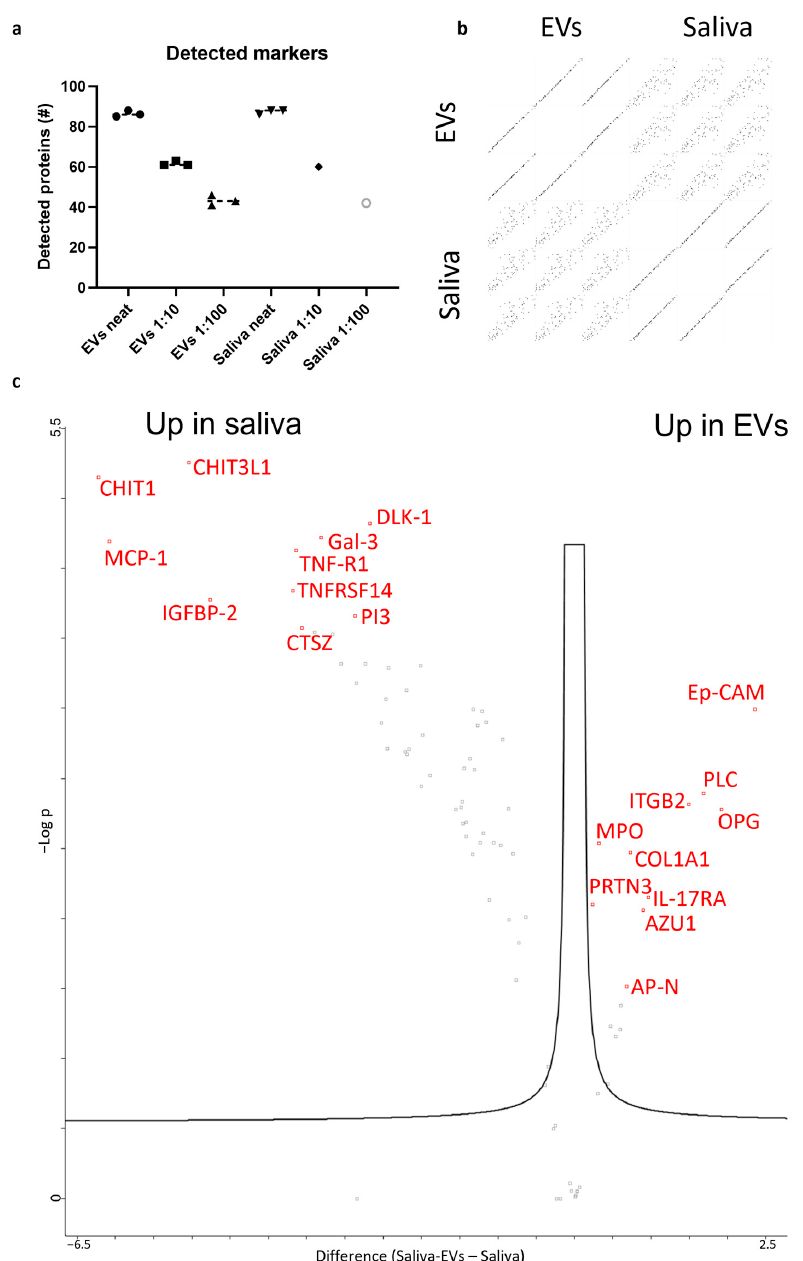
Figure 3. Proximity extension assay of saliva and saliva-EVs. ( a ) Scatter plot indicating the number of detected proteins in different dilutions of saliva and saliva-EVs. ( b ) Both saliva and saliva-EV samples showed a high correlation between samples within each group, while the inter-group correlation was lower. ( c ) A volcano plot demonstrating differences between the groups. The top 10 differentially expressed proteins in each group are